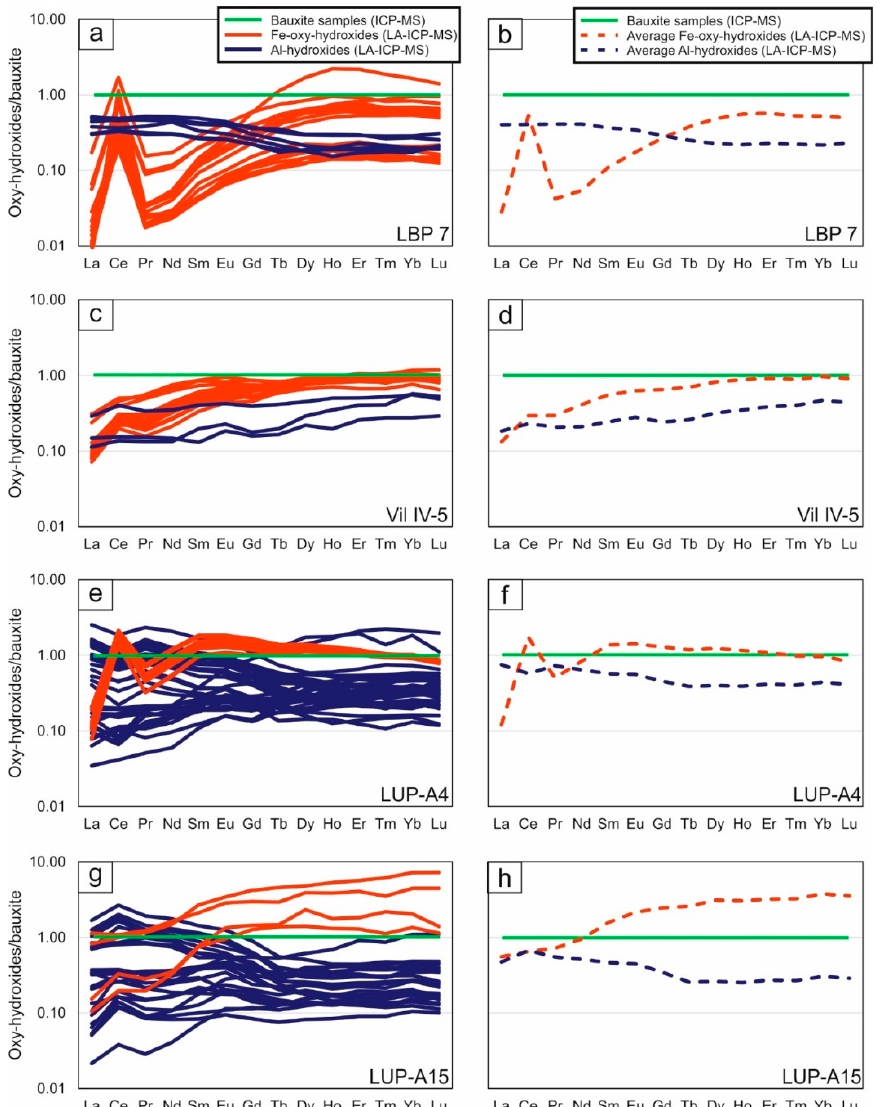
Figure 7. REE concentrations obtained with in ‐ situ LA ‐ ICP ‐ MS analysis, normalized to the corresponding bulk bauxite samples. Les Baux ‐ de ‐ Provence Al ‐ and Fe ‐ (oxy) ‐ hydroxide ( a ) individual data and ( b ) average compositions; Villeveyrac Al ‐ and Fe ‐ (oxy) ‐ hydroxide ( c ) individual data and ( d ) average compositions; Loupian: top of the profile Al ‐ and Fe ‐ (oxy) ‐ hydroxide ( e ) individual data and ( f ) average compositions; Loupian: bottom of the profile Al ‐ and Fe ‐ (oxy) ‐ hydroxide ( g ) individual data and ( h ) average compositions.